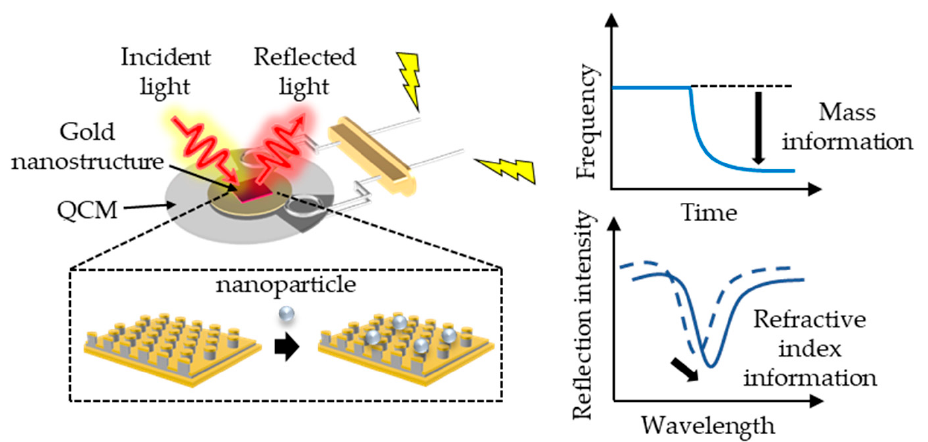
Figure 1. Concept of a device for simultaneously measuring mass and corresponding refractive index by QCM and LSPR